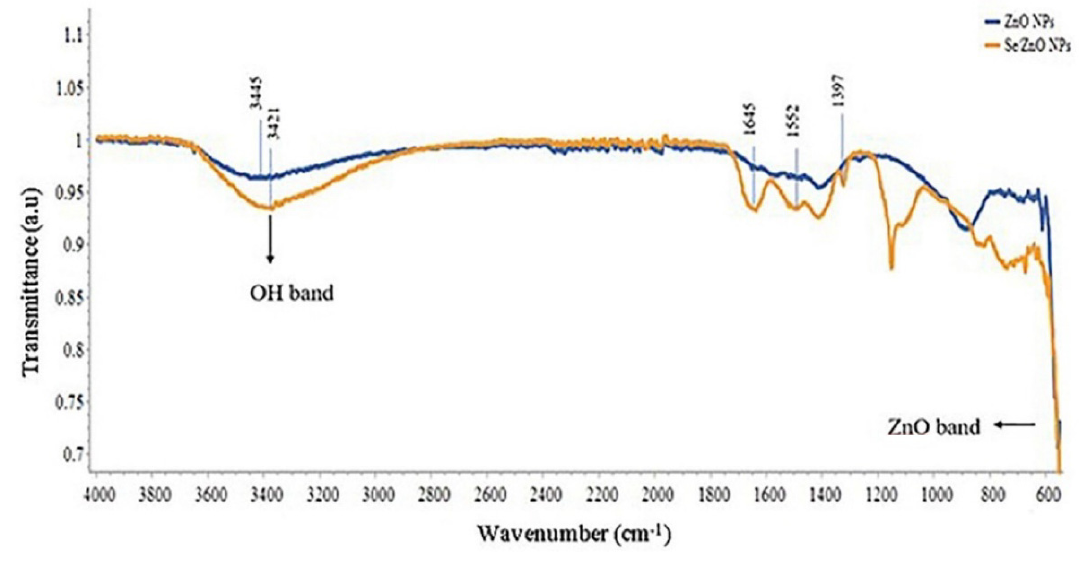
Figure 3. FTIR analysis of ZnO NPs and Se/ZnO NPs.